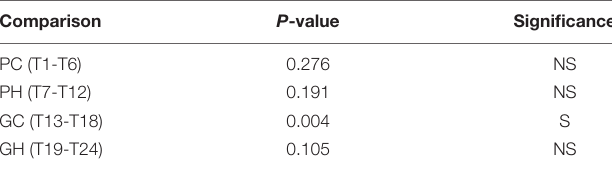
TABLE 1 | β -diversity analyses comparing the gut bacterial profile of wild Anastrepha fraterculus larvae collected from different trees from the same host fruit species and geographic